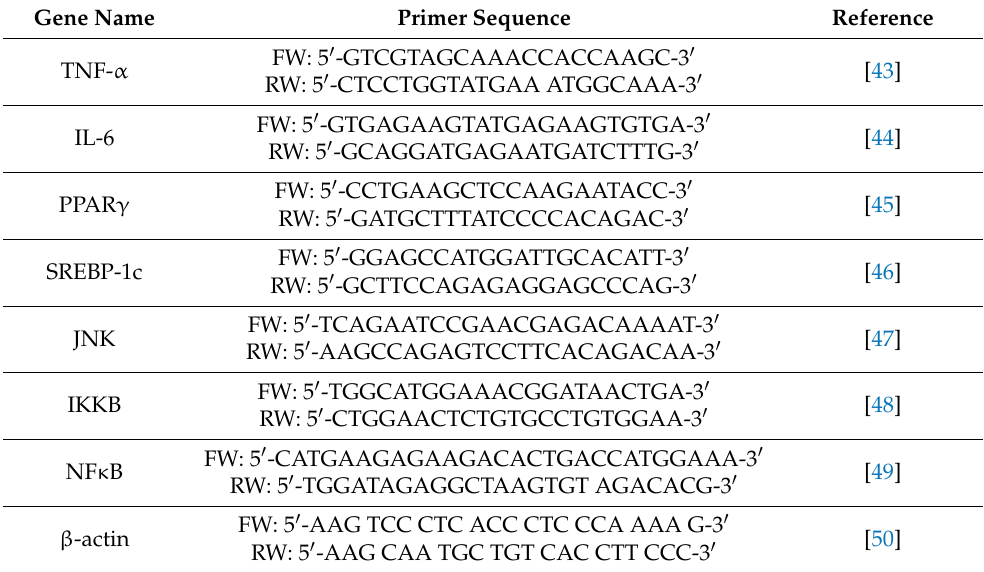
Table 3. Sequence of the primers used in gene expression